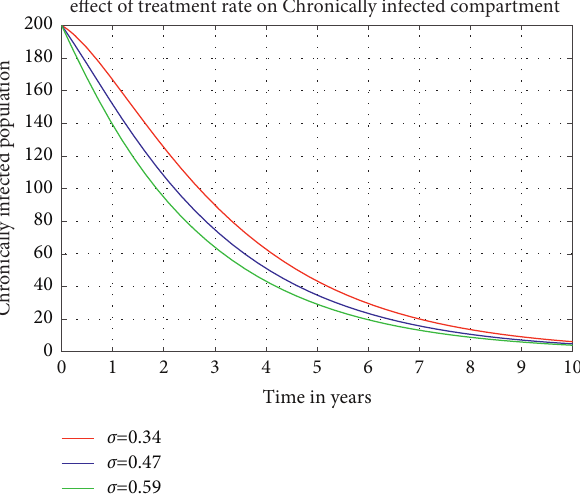
Figure 11: Effect of transfer rate on acutely infected population.